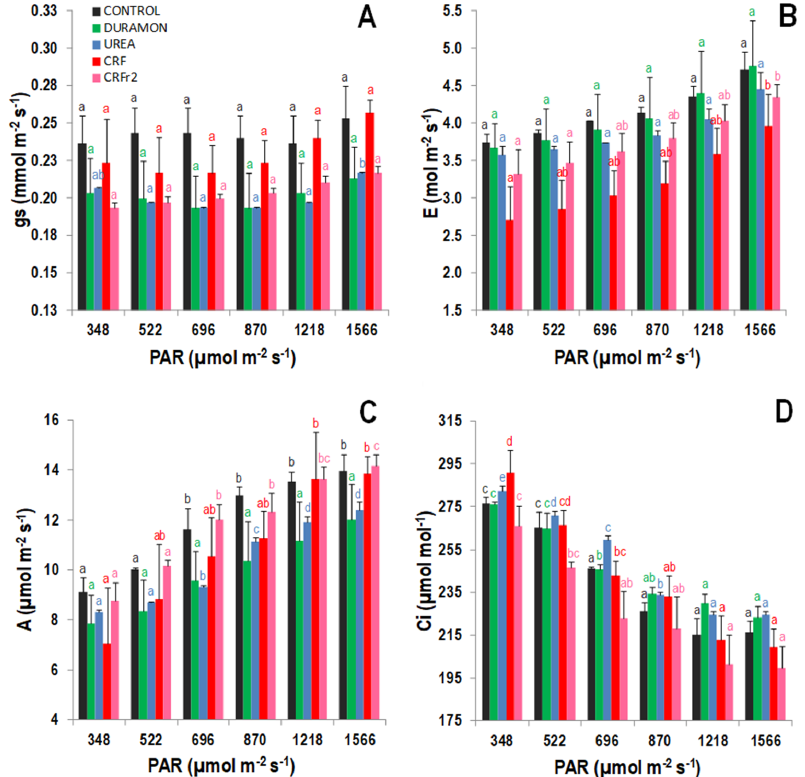
Figure 2. Gas exchange responses, on the microscale experiment, to the di ff erent photosynthetically active radiation (PAR) rates of Oryza sativa treated with fertilizers CRF, CRF r2 , DURAMON ® , UREA, and the CONTROL (no fertilizer applied) in the phenological booting stage. ( A ) Stomatal conductance, ( B ) transpiration rate, ( C ) photosynthetic rate, and ( D ) substomatal CO 2 concentration. Values represent means ± SD ( n = 5). Di ff erent letters (same color) indicate statistically significant di ff erences between different PAR levels for each treatment (ANOVA, p < 0.05).